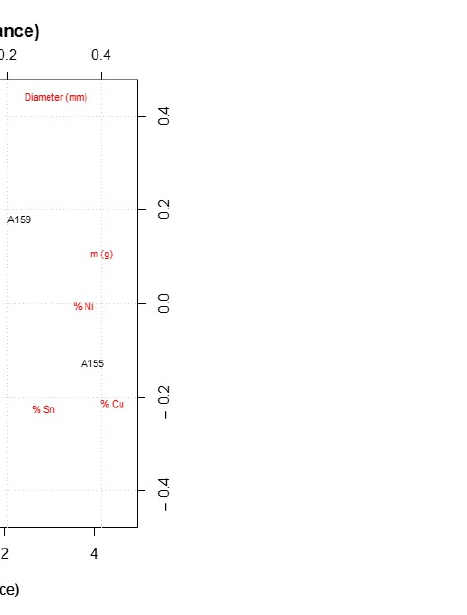
Figure 6. Biplot (score and loading scatter diagram) from PCA: scores are in black, loadings in red.